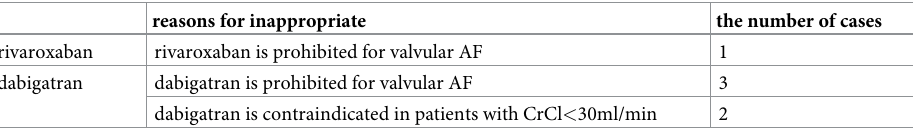
Table 5. Reasons for the inappropriate selection of